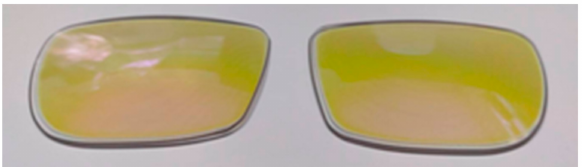
Figure 1. The picture of the notch filter coated on spectacle lenses.